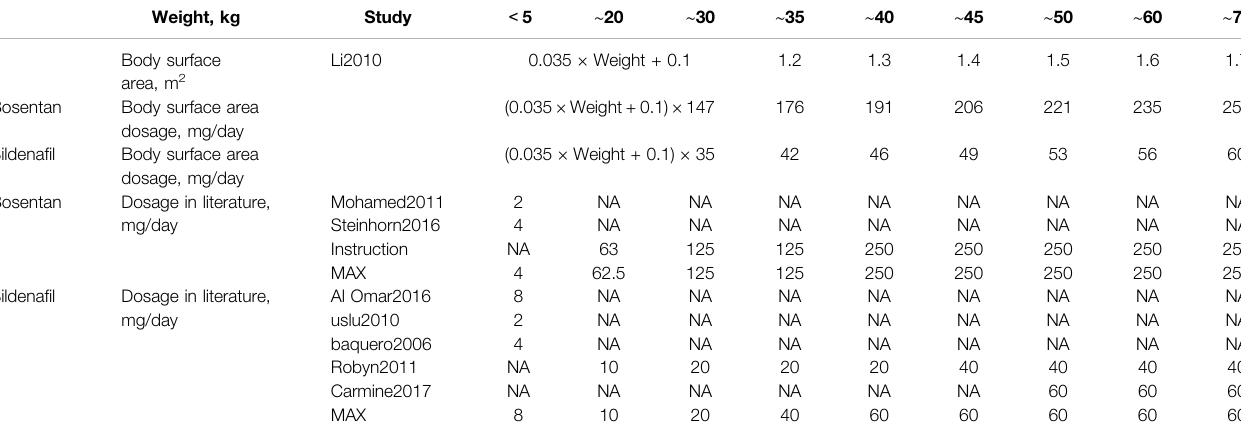
TABLE 4 | Body surface area dosage and dosage in literature of bosentan and sildena fi l. Weight, kg